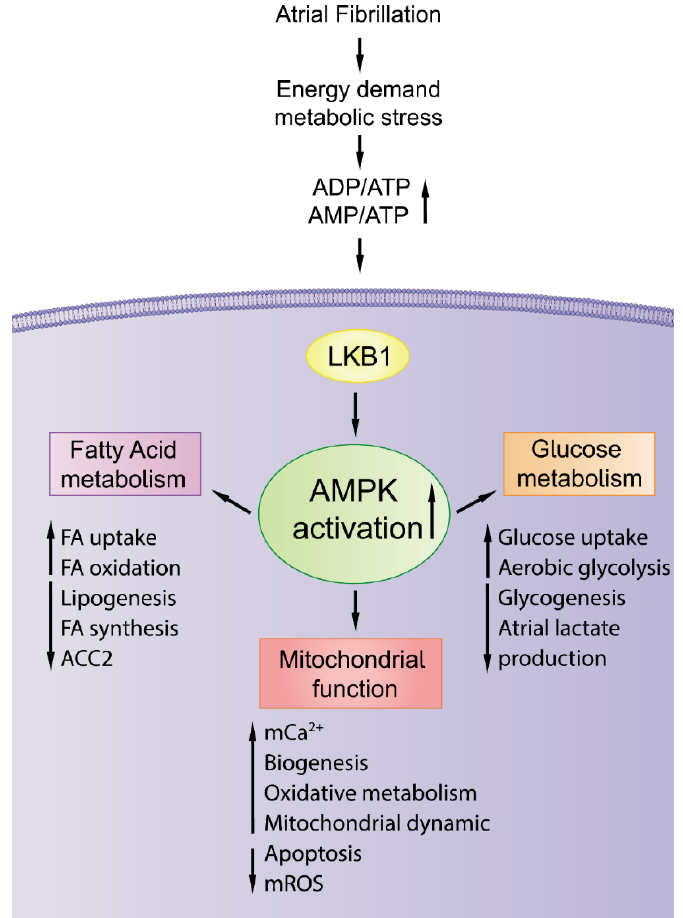
Figure 2. Schematic illustration of the role of AMPK activation in antiatrial arrhythmogenesis. Atrial fibrillation enhances energy demand and induces metabolic stress. Metabolic stress causes an increase in ADP/ATP and AMP/ATP ratio. Elevated AMP/ATP or ADP/ATP ratio under metabolic stress activates AMP-activated protein kinase (AMPK) through the phosphorylation by LKB1 in cardiomyocytes. AMPK activation enhances energy production and limits energy consumption through FA and glucose metabolism and mitochondrial homeostasis. ACC, acetyl CoA carboxylase; FA, fatty acid; LKB1, liver kinase B1; mROS, mitochondrial reactive oxygen species.